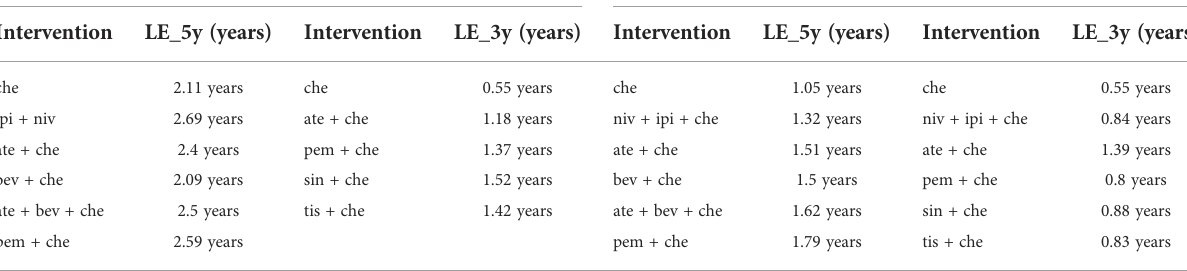
TABLE 3 Life-years gained by patients with different levels of PD-L1 expression. Patients with PD-L1 expression ≥ 50% Patients with PD-L1 expression < 1% Intervention LE_5y (years) LE_3y